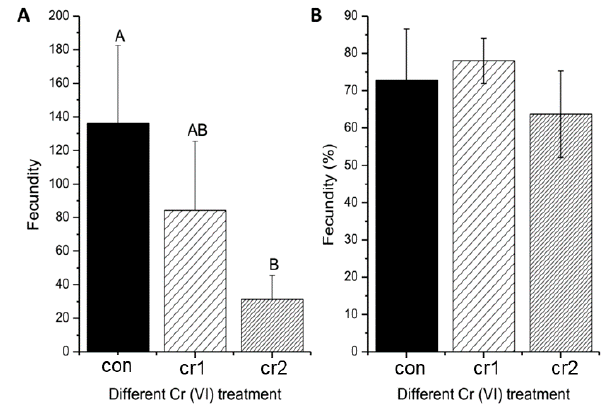
Figure 2. The change of parental reproduction induced by long-term Cr(VI) exposure on marine medaka. ( A ) the change of female fecundity, different upper case means the significant differences among different treatment ( p ≤ 0.01); ( B ) the change of fertilization rate. For different treatment group, the number of biological samples is 4.